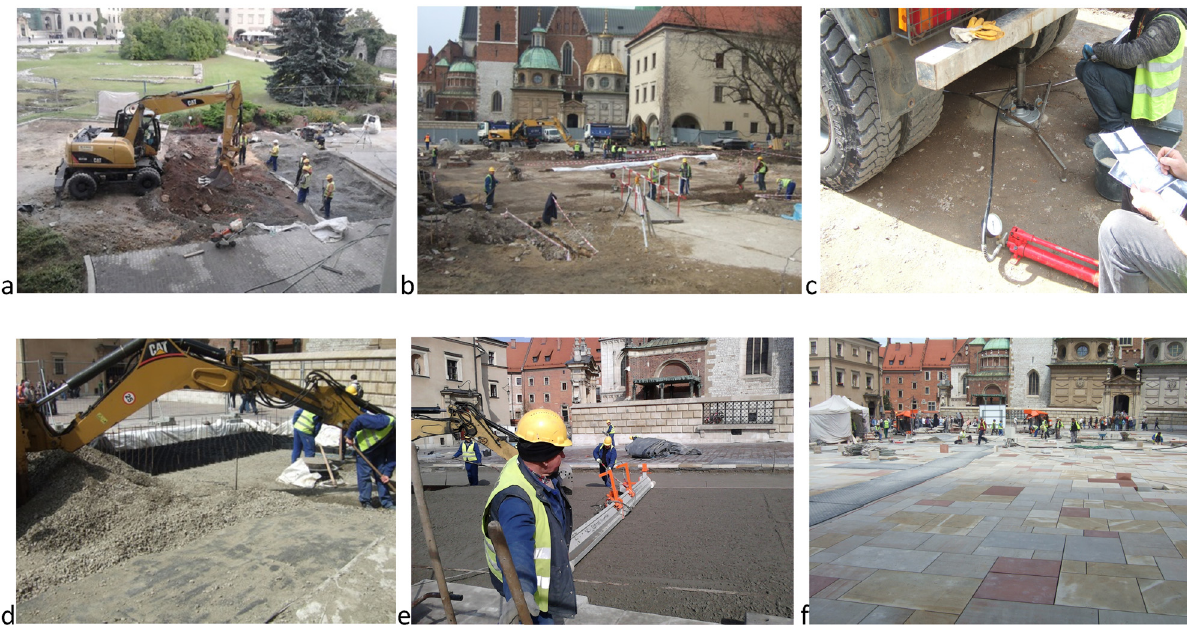
Figure 3: Renovation of the surface of the outer courtyard of Wawel Castle: ( a ) dismantling of existing surface, ( b ) soil strengthening and pro fi ling, ( c ) soil strength veri fi cation, ( d ) application of various variants of soil strengthening, ( e ) laying the base course and ( f ) laying the stone surface layer. Source: photo Grzegorz Ś ladowski.